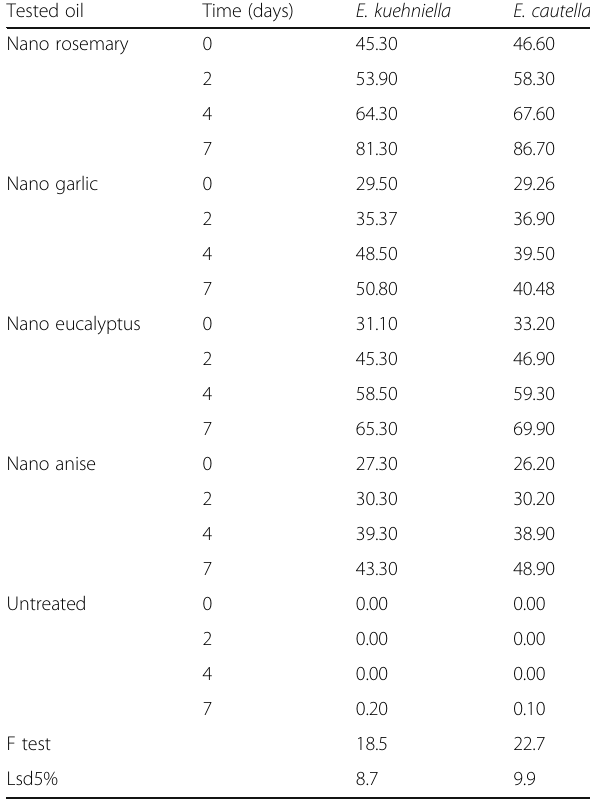
Table 1 Accumulative percentage mortality of tested insect larvae (third instar) during 1 week in treated foam with different nano oils Tested oil Time